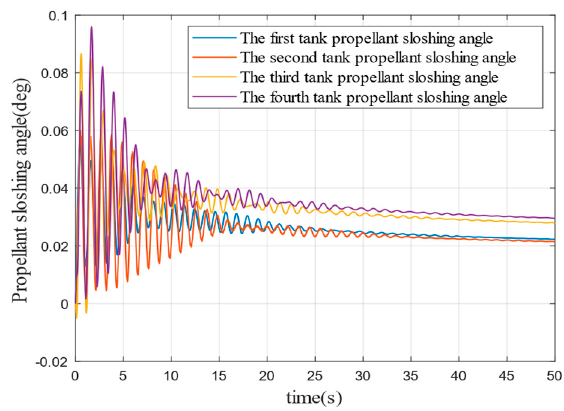
Figure 21. Fuel sloshing angle with considering external disturbances.